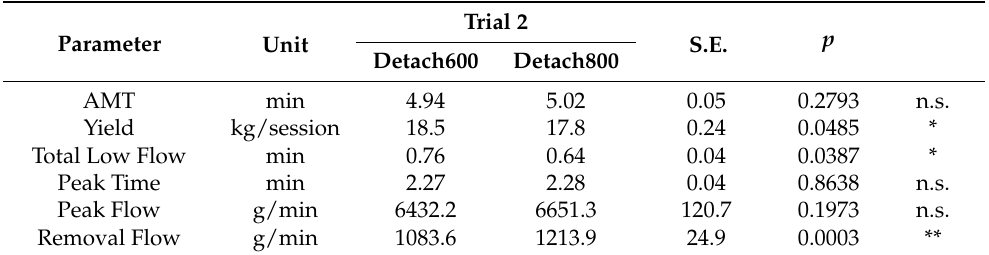
Table 2. Corrected least-square means (LSMeans), standard errors (S.E.s), and related statistical differences of Trial 2, where 2 detachment flows were tested. The control had the detachment flow set to 600 g/min, and the experiment had the detachment flow set to 800